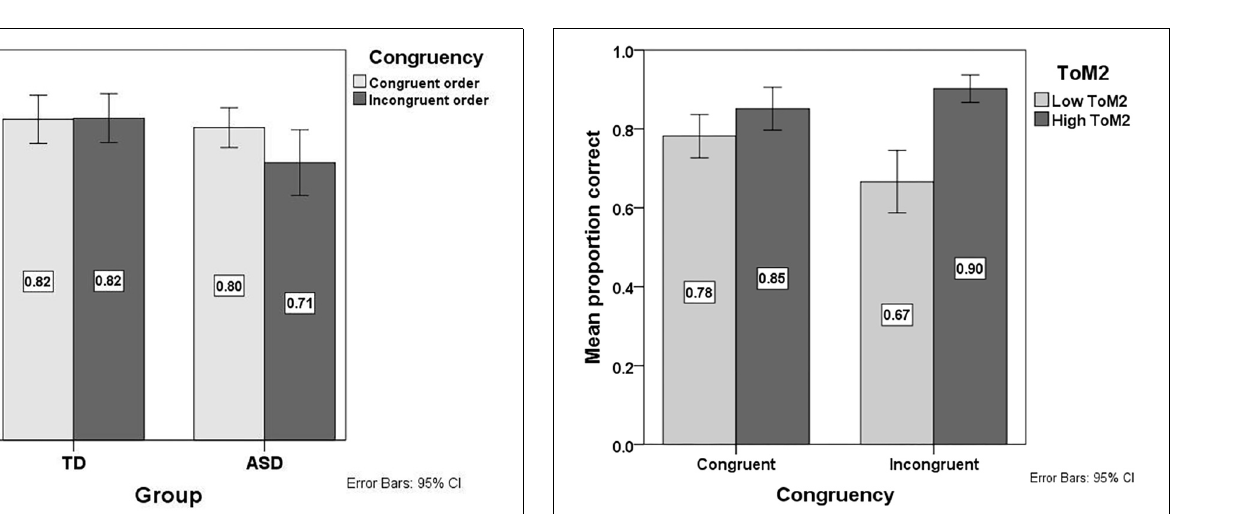
FIGURE 2 | Mean proportion of correct responses in the language comprehension task per Congruency condition (Congruent vs. Incongruent) and Group (TD vs. ASD).